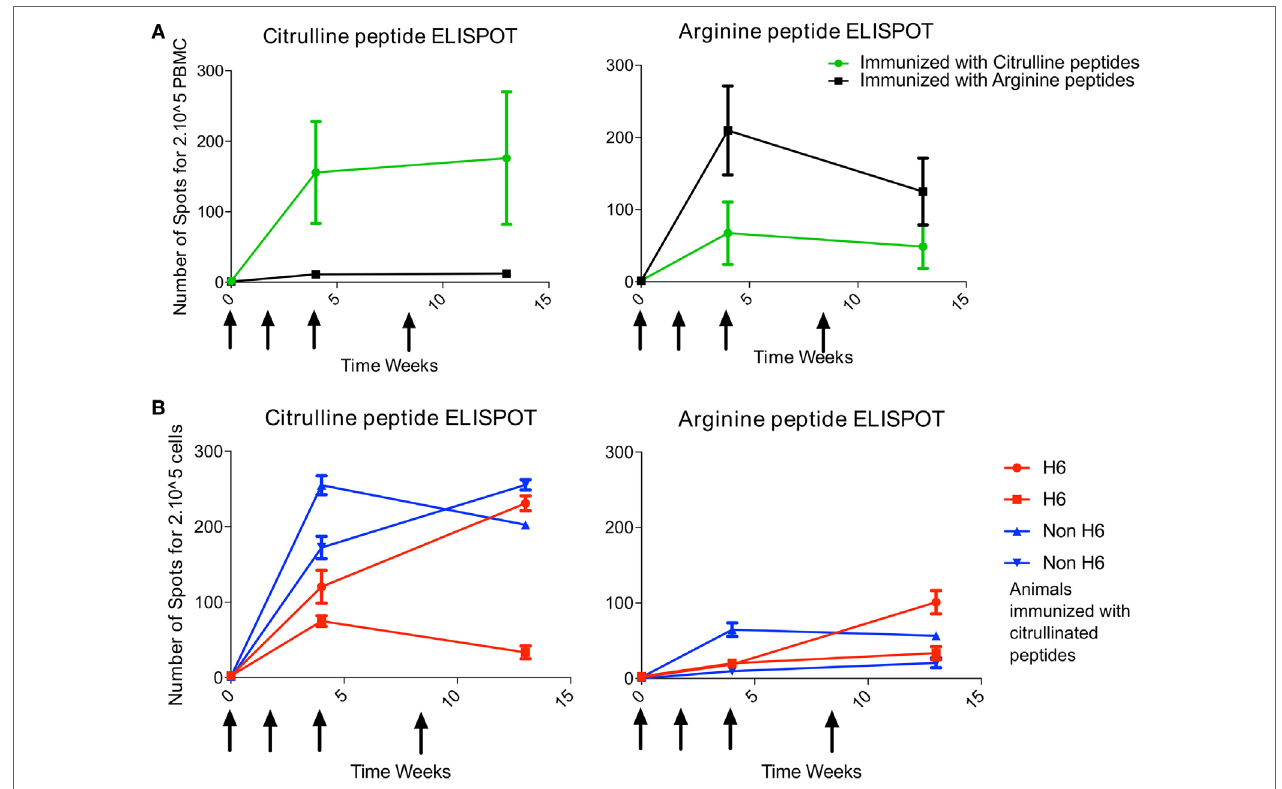
FigUre 1 | T-cell response to immunization is citrulline dependent. Animals were immunized at weeks 0, 2, 4, and 8 (arrows) with pooled citrulline ( n = 4) or arginine ( n = 2) peptides: Vim59 and 66, Fg79, and Agg89. (a) Antigen-specific T-cell response of PBMCs was assessed by interferon-gamma (IFN γ ) ELISPOT directed against the pool of the same citrullinated or arginine peptides. Data are mean ± SD values for individual animals (performed in triplicate). (B) H6 ( n = 2) and non-H6 ( n = 2) macaques were immunized with pooled Vim59 and 66, Fg79, and Agg89 peptides at weeks 0, 2, 4, and 8 (arrows). Antigen-specific T-cell response of PBMCs was assessed by IFN γ ELISPOT directed against the pool of the same citrullinated or arginine peptides. Data are mean ± SD for individual animals (performed in triplicate). PBMC, peripheral blood mononuclear cell; ELISPOT, Enzyme Linked